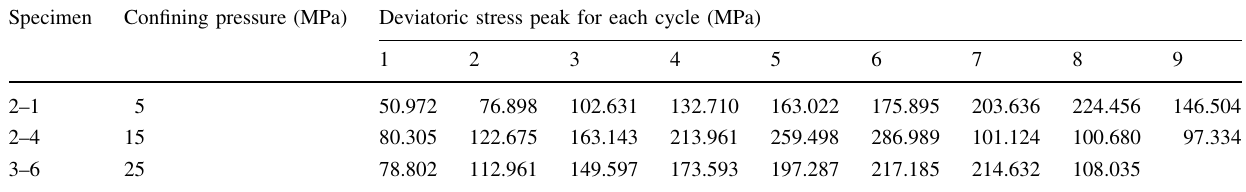
Table 1 Deviatoric stress peak corresponding to each cycle of cyclic loading test Specimen